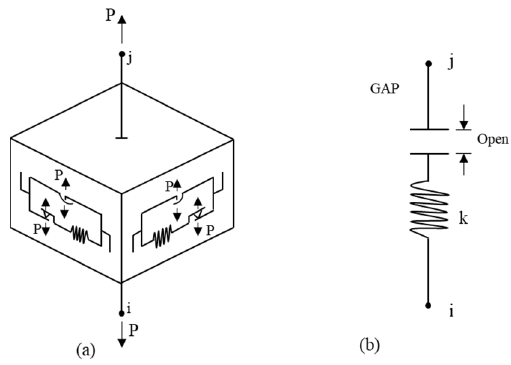
Figure 2. Boundary condition in SAP2000: ( a ) FC element, ( b ) GAP element.